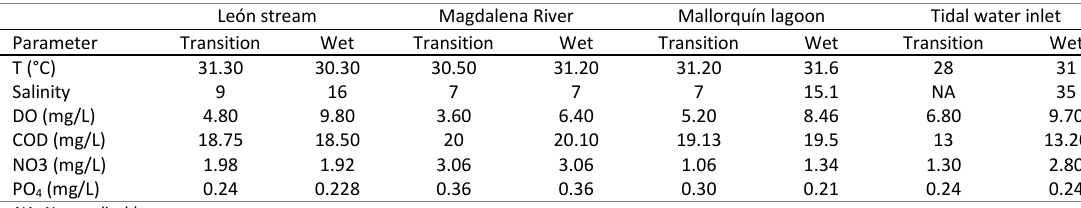
Table 4: Data concentrations for water quality simulation